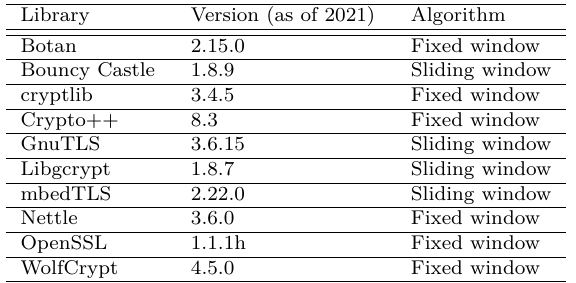
Table 1: Modular exponentiation algorithms used in RSA